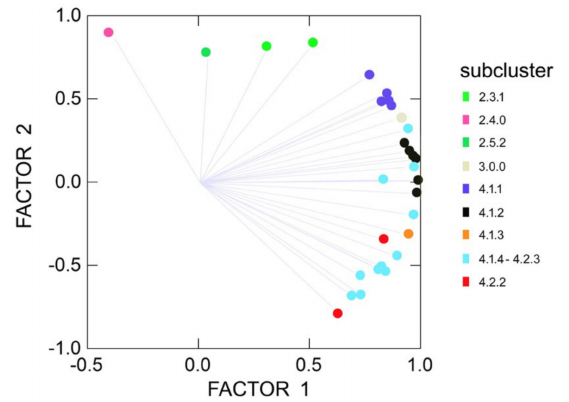
Figure 3. Plot of double factorized SCoT-ITS distances. Subcluster codes are indicated (for explana- tion, see